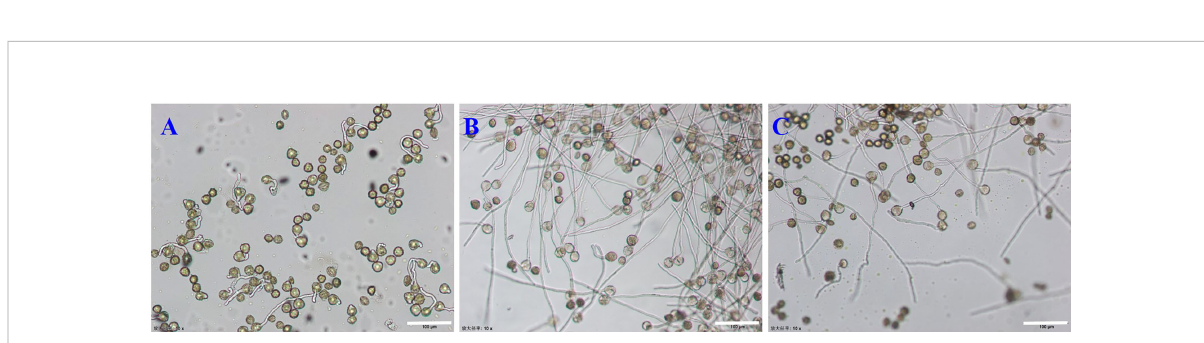
FIGURE 2 Germination rate of E. racemosa pollen in different culture media. (A) The CK1 medium; (B) The M 5 medium; (C) The M 7 medium. Bar = 150 m